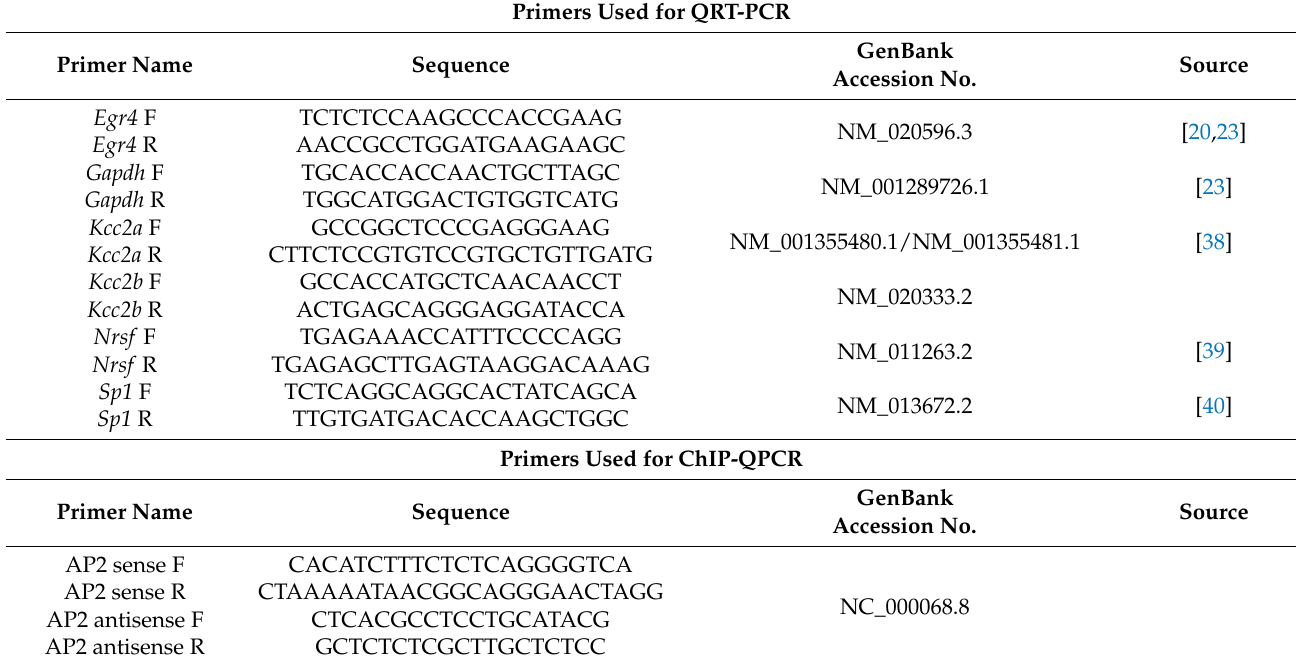
Table 1. Cont. Primers Used for